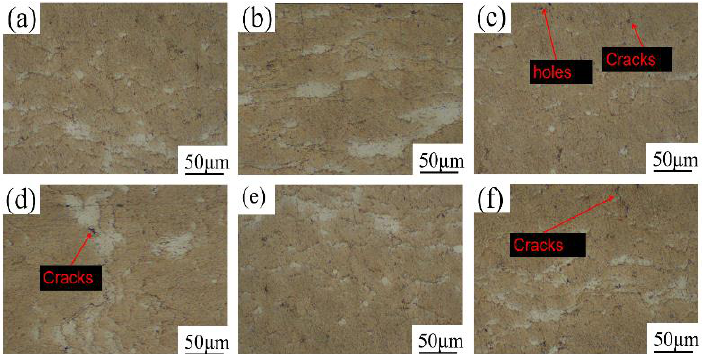
Figure 5. Microstructure of coating sections at different spraying distances: ( a ) 18 mm, ( b ) 20 mm, ( c ) 22 mm, ( d ) 25 mm, ( e ) 27 mm, ( f ) 30 mm.